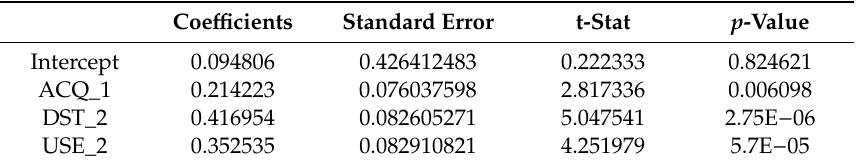
Table 6. Results of regression analysis after rejection of factors with lower significance as measures by Student’s